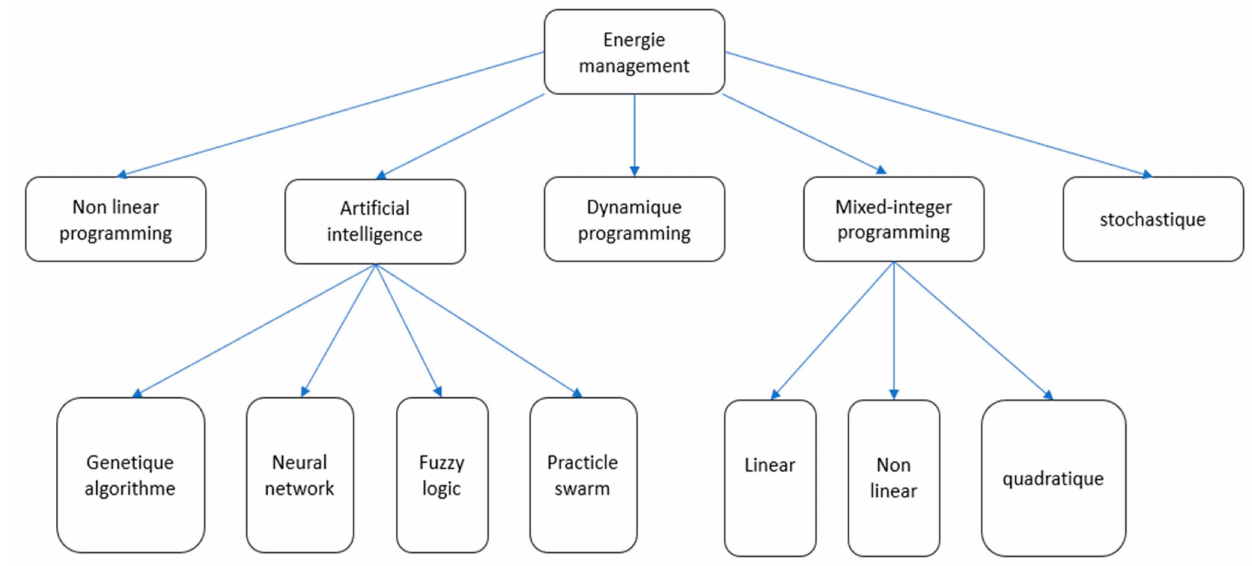
Figure 4. Energy management methods